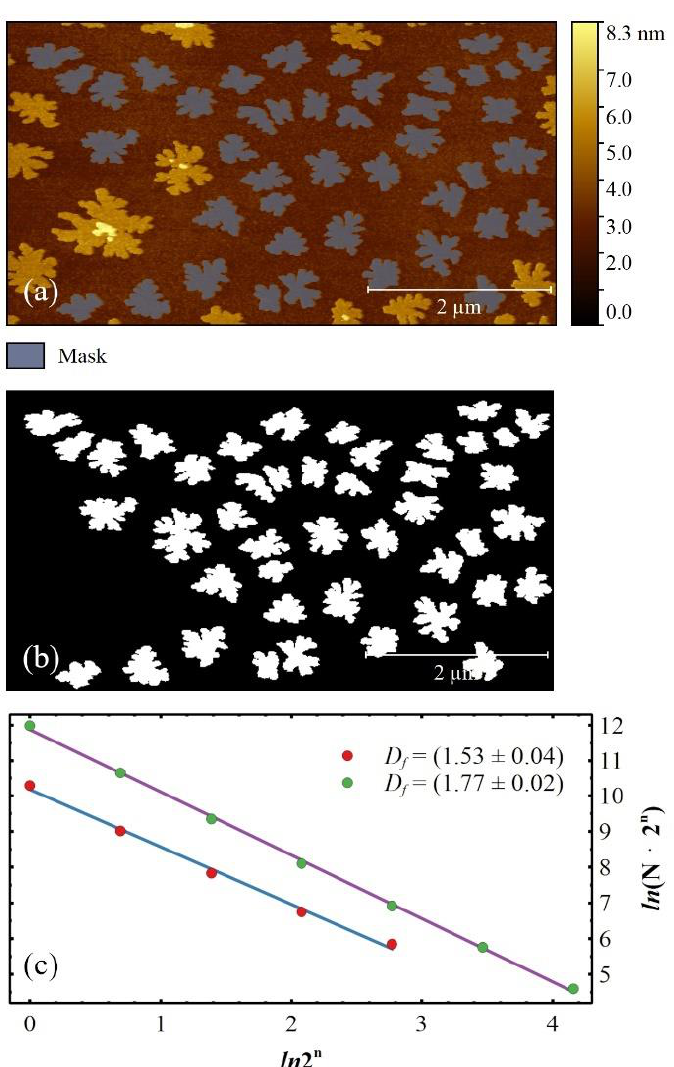
Figure 1. ( a ) Typical AFM image of 6T islands grown by Organic Molecular Beam Deposition (OMBD) on native SiO x in UHV ( Θ = 1.5 ML and T S = 50 ◦ C). The bimodal growth is highlighted by both thresholding and filtering procedures (east bay coloured mask); ( b ) Binarized extracted mask with an average islands area of ~2850 px 2 , correspondent to a box size of ~55 px, closeness to 64 px, i.e., 2 6 px as a power of 2; ( c ) Fractal dimension D f calculated for seven box sizes: 2 0 , 2 1 . . . 2 6 px (green dots). The natural logarithm ( ln ) of the number of covering boxes ( N ) of each size times the length of a box edge (2 n ) is plotted against the ln (2 n ). A straight-line with a negative slope B results, and D f is calculated as 1 − B . In the x -axis, the box size changes a few units, i.e., ln (2 6 ) = 6 · ln 2~4.16, while in the y -axis, N spans 5 orders of magnitude, from few units for 2 6 to ~1.6 × 10 5 for 2 0 . The D f is affected by the average area of 6T islands, returning a smaller value of D f for a smaller average area (red dots, Θ = 1.08 ML and T S = 50 °C).